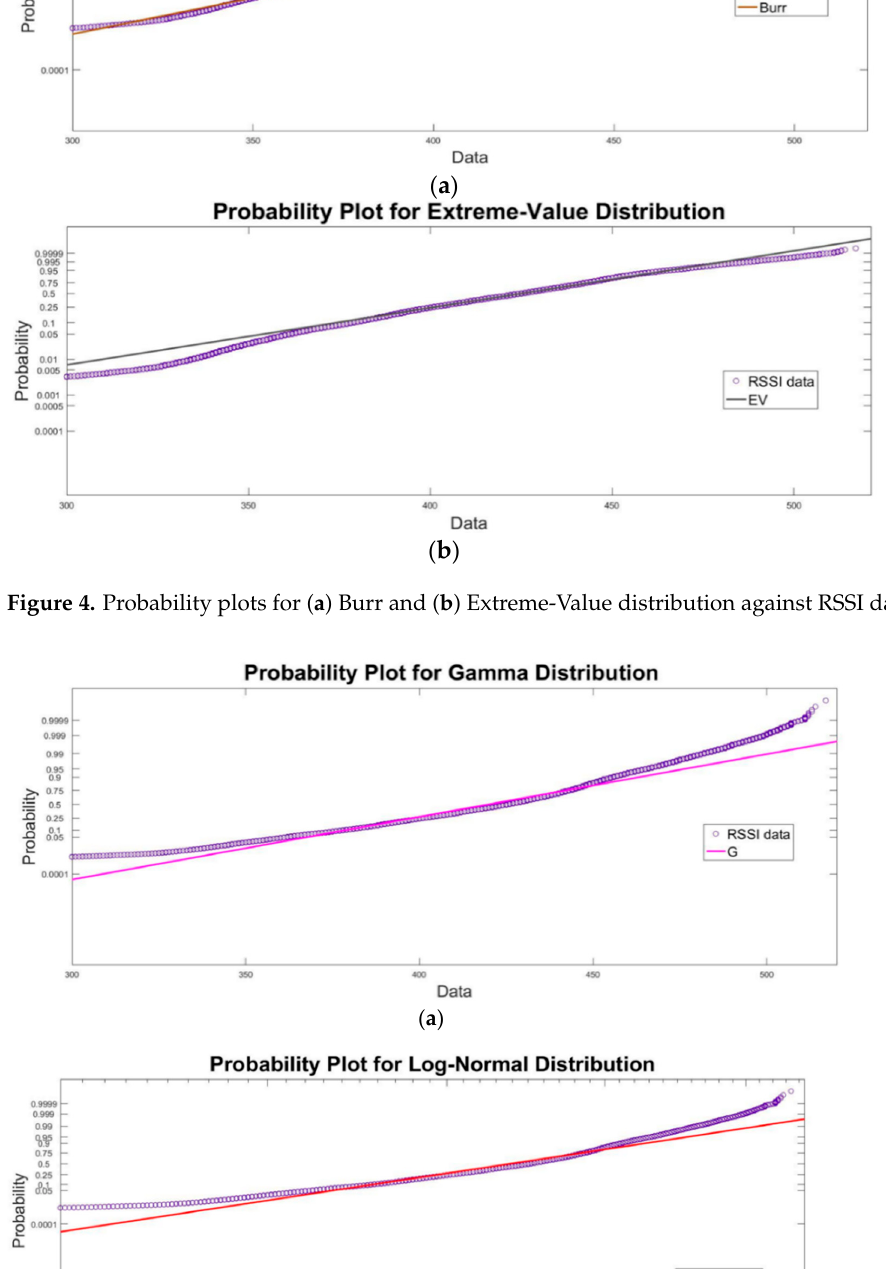
Figure 6. Probability plot for Weibull distribution against RSSI data. 3.2. Jensen–Shannon Divergence Another method of measuring the similarity of two probability distributions is the so-called Jensen–Shannon divergence (JSD). The JSD is based on the KL divergence, how- ever it exhibits a few but important differences with it, namely it is symmetric and it al- ways has a finite value. The square root of JSD, also defined as the JS distance, is given by [23],